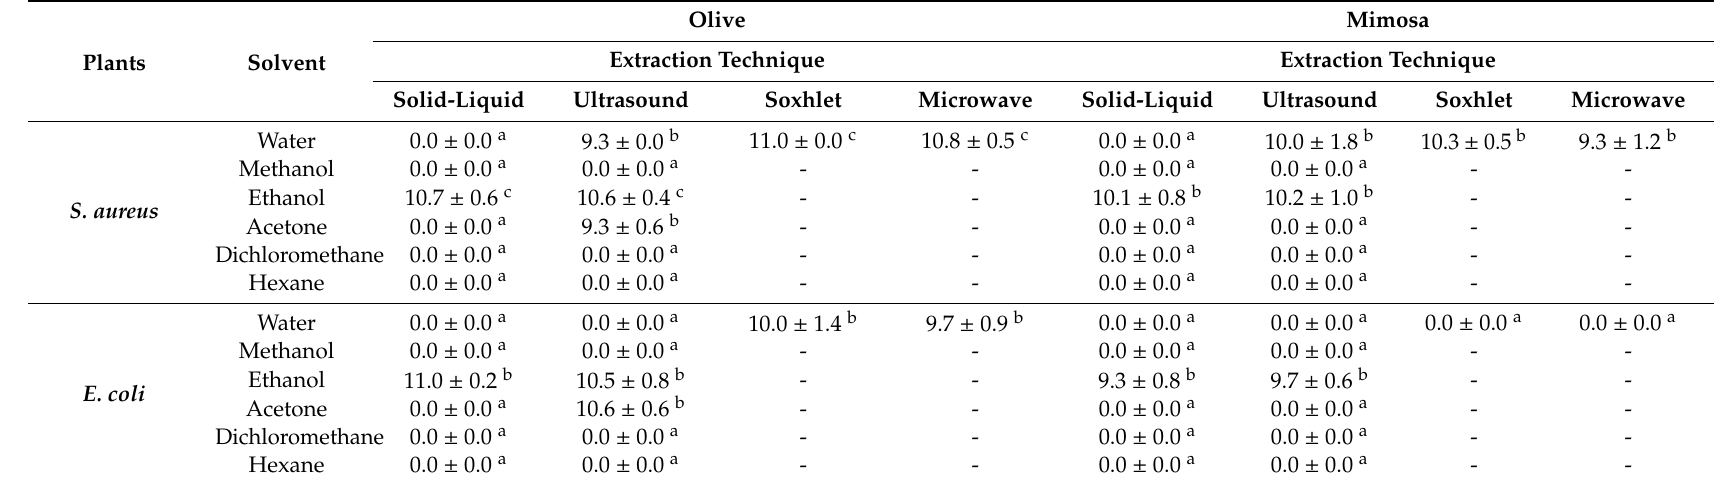
Table 3. Antibacterial activity of olive and mimosa leaf crude extracts at 5 mg / mL obtained with the di ff erent extraction techniques and the selected solvents against S. aureus and E. coli (expressed in diameter of inhibition zone